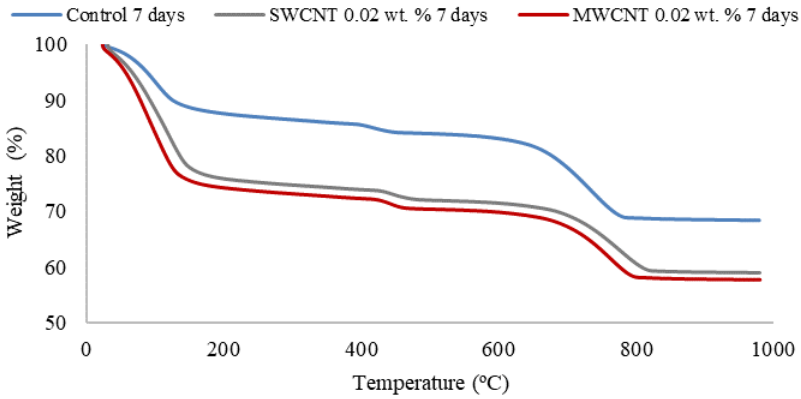
Figure 2. SEM micrographs 7 days after the preparation of ( a ) control sample, ( b ) 0.02 wt.% MWCNTs reinforced sample and ( c ) 0.02 wt.% SWCNTs reinforced sample.